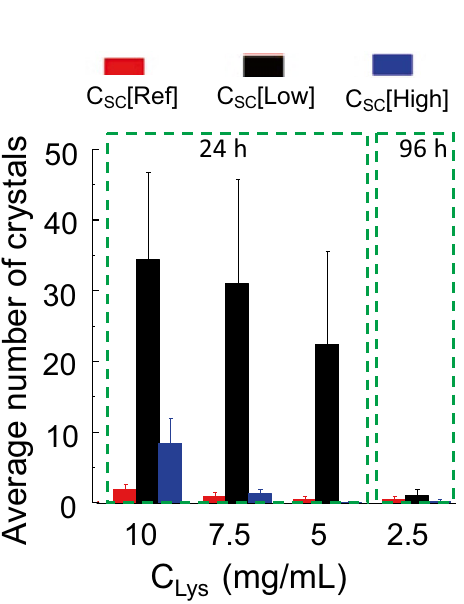
Concentration of lysozyme